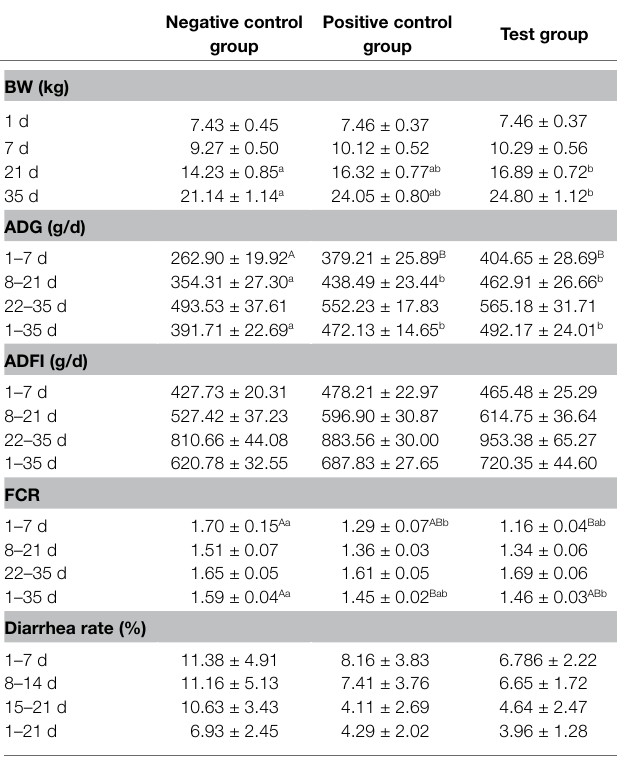
TABLE 2 | Growth performance in three groups of weaned piglets at different times. Negative control Positive control group